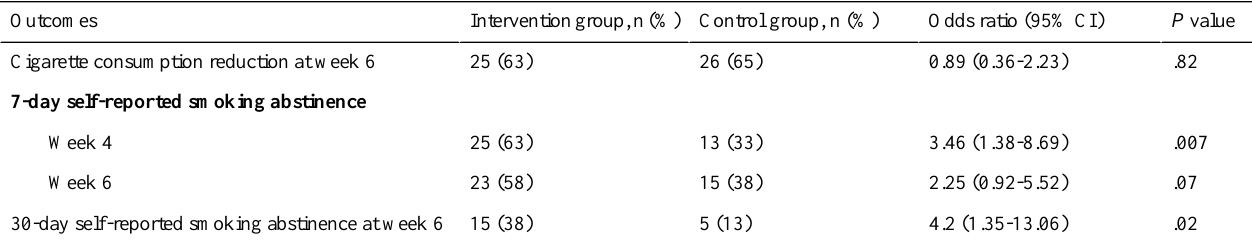
Table 3. Odds ratios for secondary